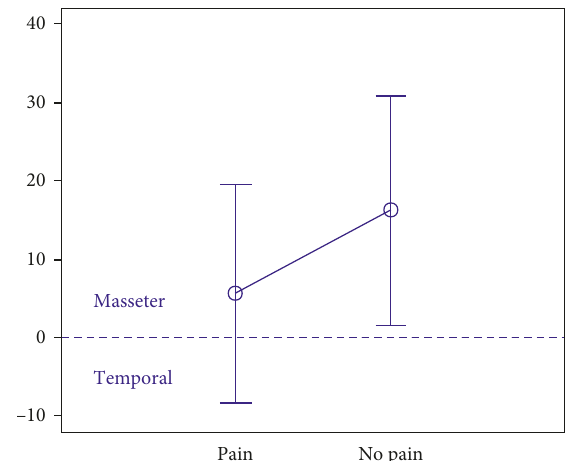
Figure 7: Activity index during swallowing in group of healthy